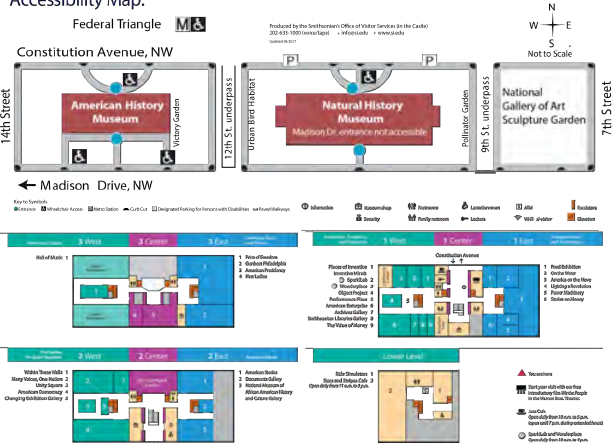
Figure 10. Analyzing plan for accessibility for The National Museum of American History Produced by the museum